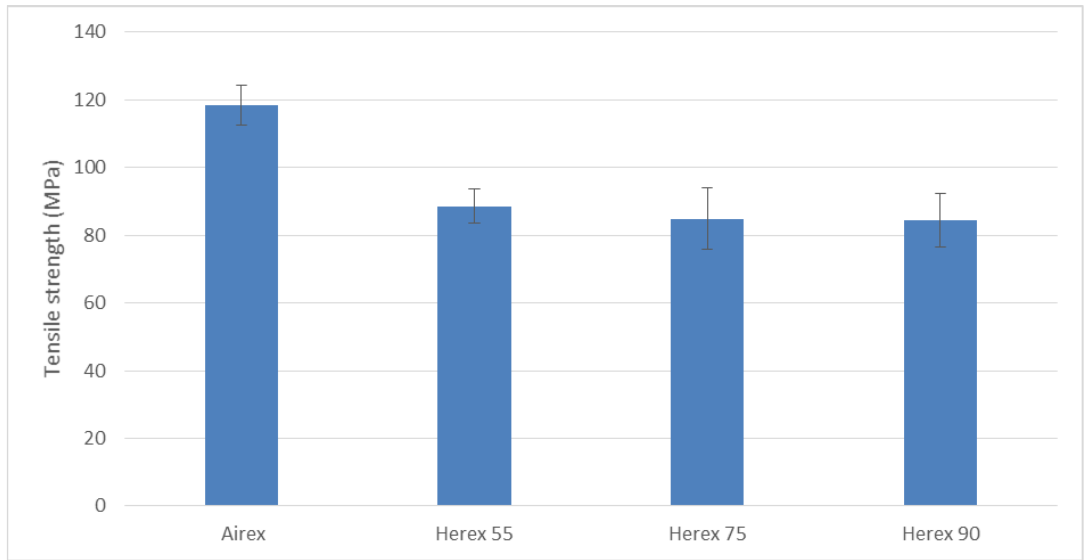
Figure 19. Young’s modulus during tension of the tested composites.